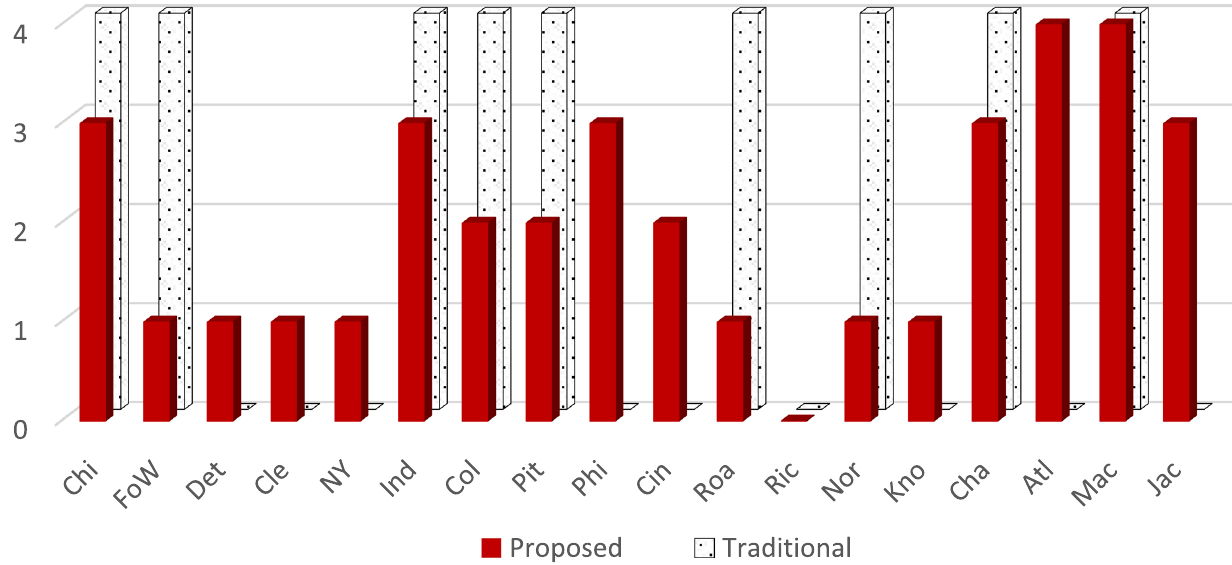
Fig. 9 Comparing the impact of the two protection